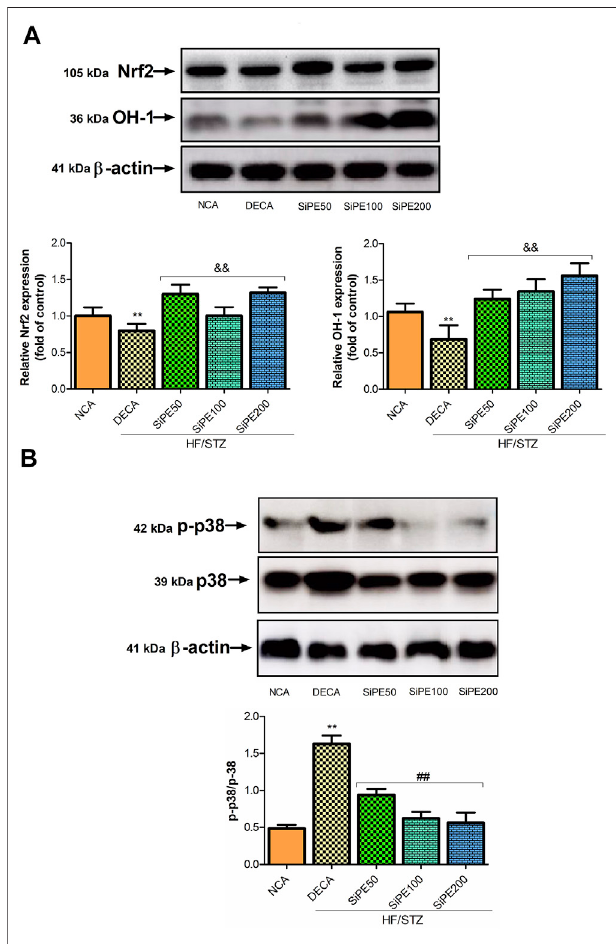
FIGURE 10 | Protein expressions of p-38, p-p38, Nrf2 and HO-1 in the brain tissues from NCA, DECA and SiPE treated groups. Data are presented as mean ± SD ( n (cid:2) 6) and one-way ANOVA test was applied. ** p < 0.001 indicates statistical signi fi cance compared to NCA group. ## p < 0.001, && p < 0.01 and $$ p < 0.05 indicate statistical signi fi cance compared to DECA group.